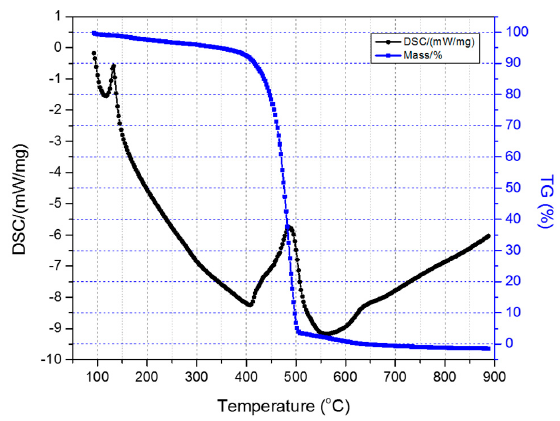
Figure 6. Combined TGA-DSC measurement of the HDPE/SKL (90:10) sample.